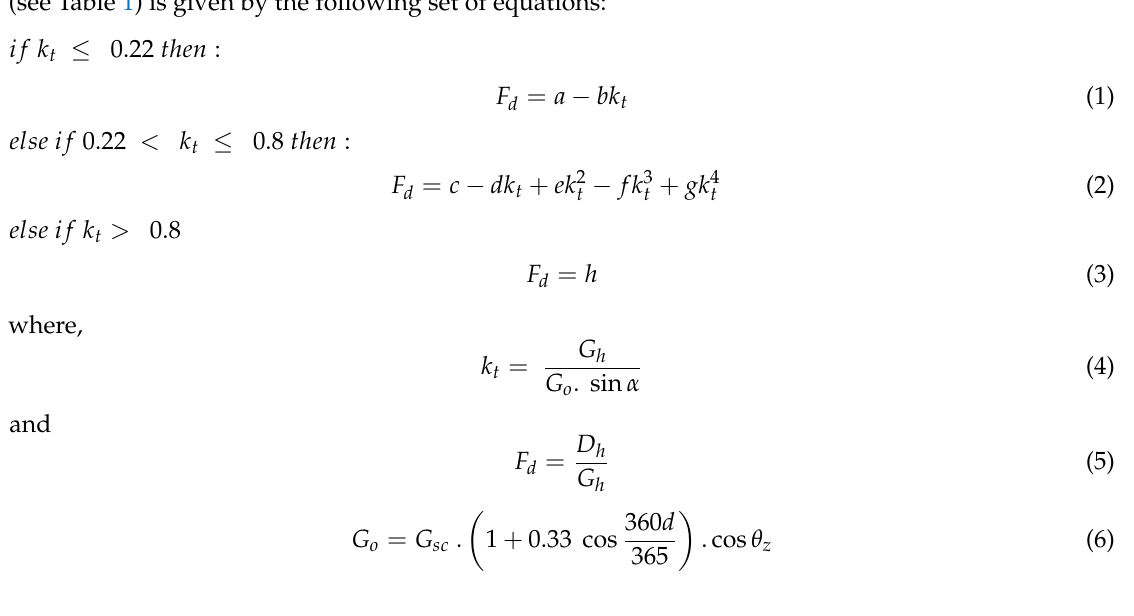
Table 1. The Erbs et al. model’s coefficients for different